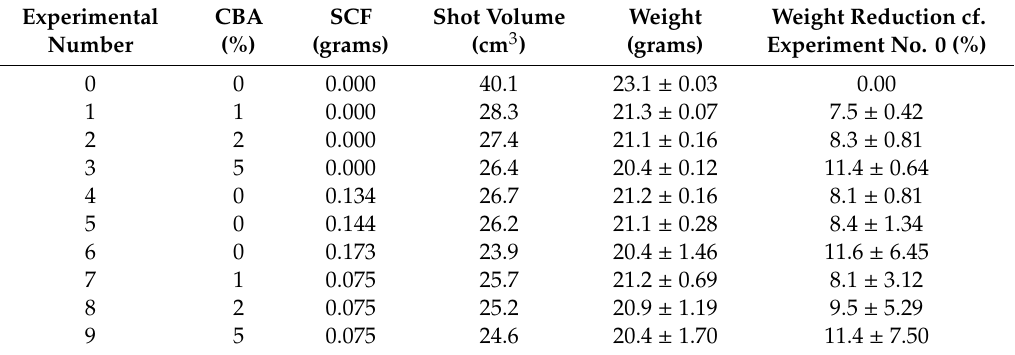
Table 1. Input processing data used for unfilled PP.